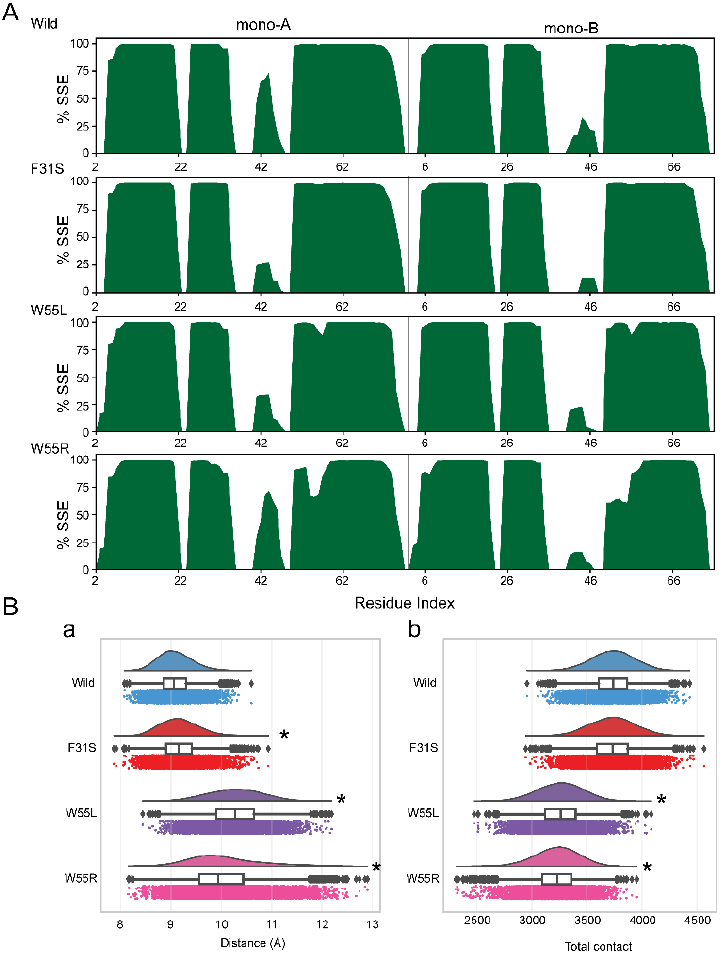
Figure 6. Changes of secondary structural elements and dimer stability. ( A ) The occupancy of the helix structure was estimated as a fraction of a percentage for wild and all variants. ( B ) Raincloud plot [54] shows the distribution and average distance between the centers of mass of monomers ( a ) and total intermonomeric contact ( b ) for all variants and wild-type structures. Annotation p -values indicates significant (* p < 0.01) in comparison to wild-type.